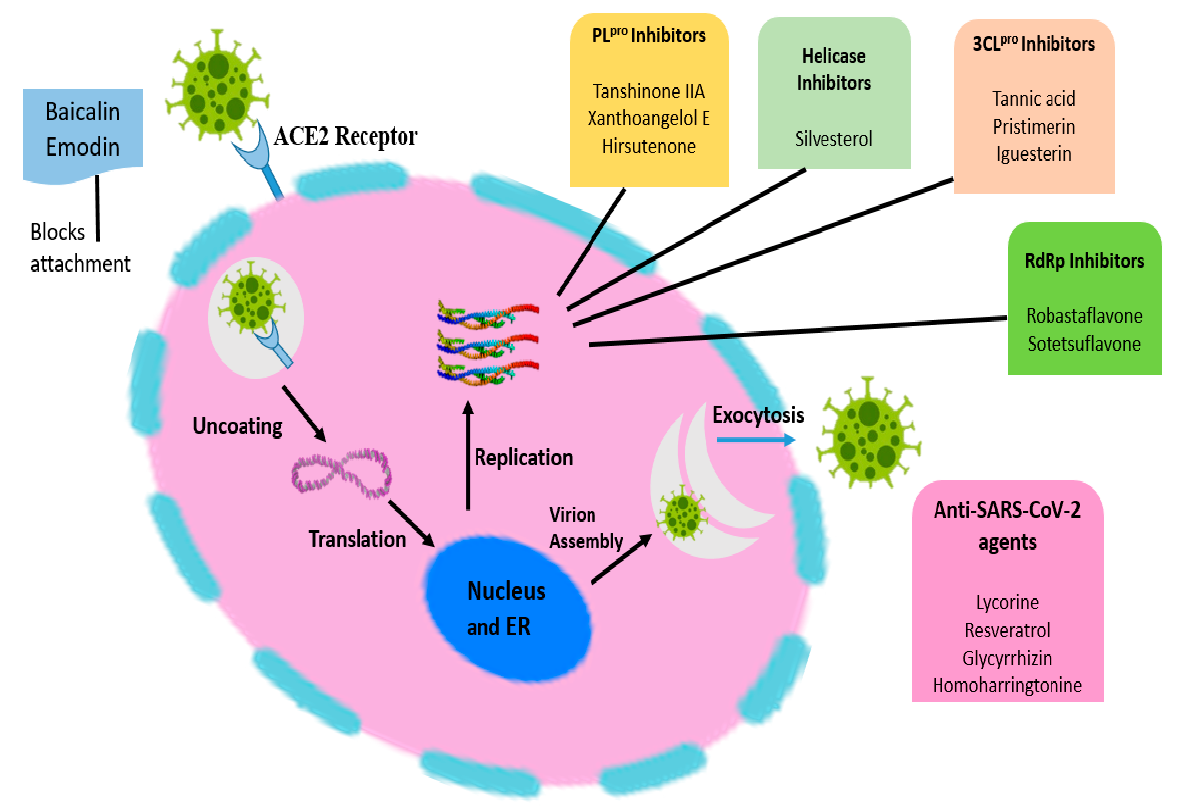
Figure 4. Role of enzyme and protein inhibitors in SARS-CoV.